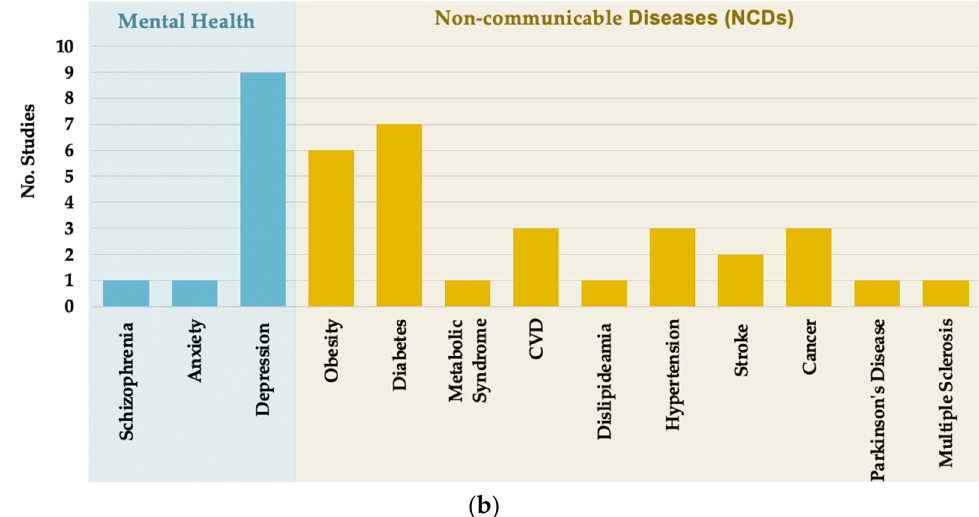
Figure 2. Frequency and type of selected studies by: ( a ) exposure; ( b ) primary outcome.